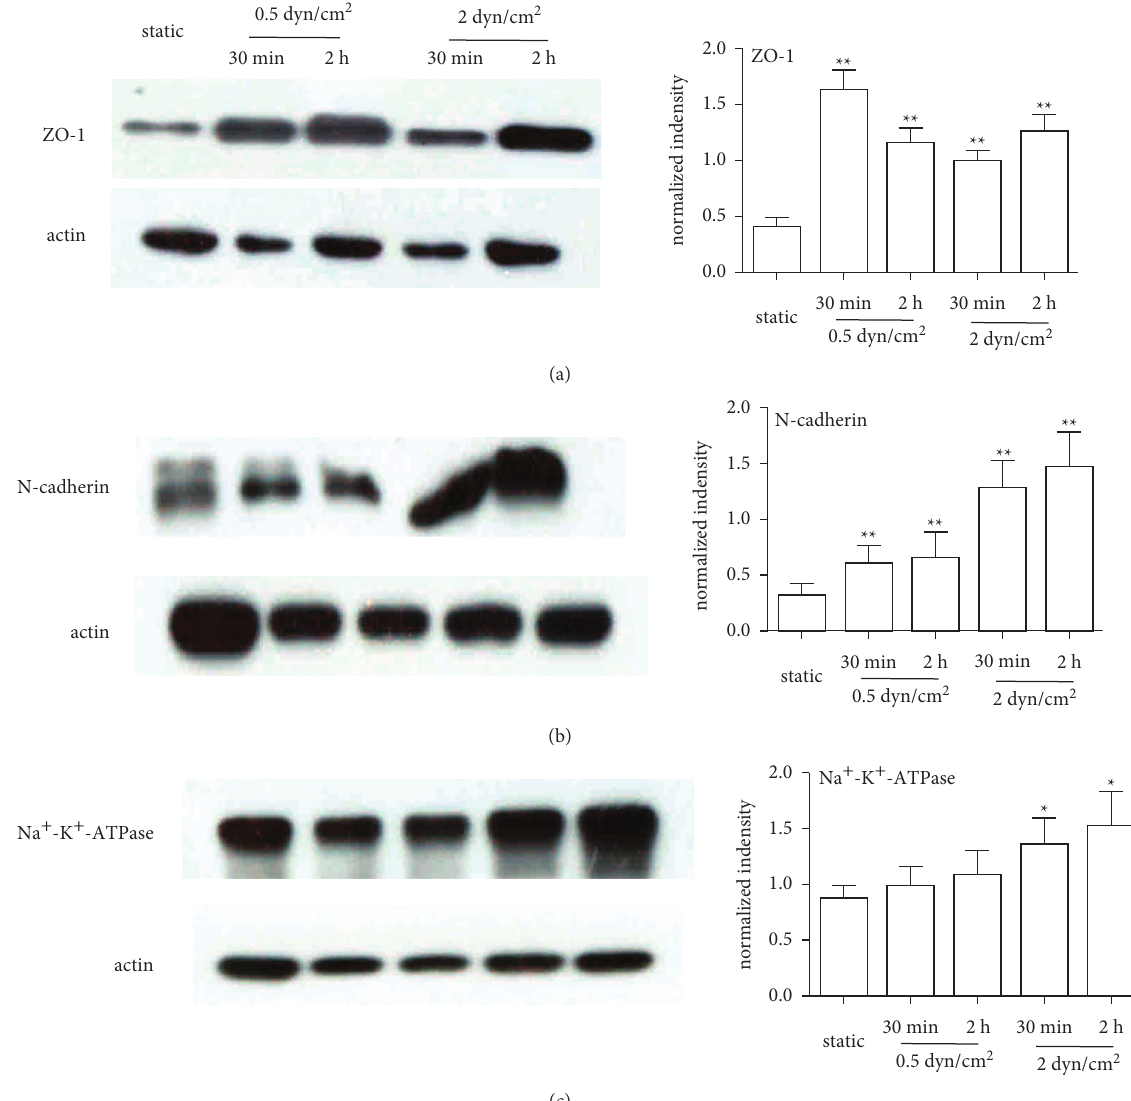
Figure 3: Effect of shear stress on the protein expression of corneal endothelial cell-related markers. (a) ZO-1 protein expression was significantly increased in the shear stress groups compared with the static group. (b) N-cadherin protein expression gradually increased with increasing shear rates and exposure time. (c) Na + -K + -ATPase protein expression was slightly increased after exposure to shear stress. All the experimental data were analysed in triplicate; ∗ P < 0 . 05, ∗∗ P < 0 .